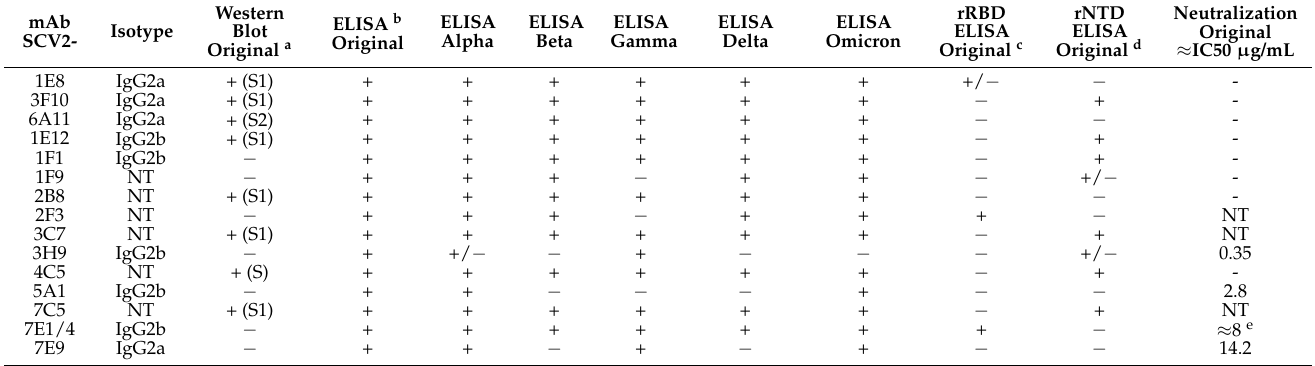
Table 1. List of anti-SARS-CoV-2 spike mAbs, characterization and behavior in assays